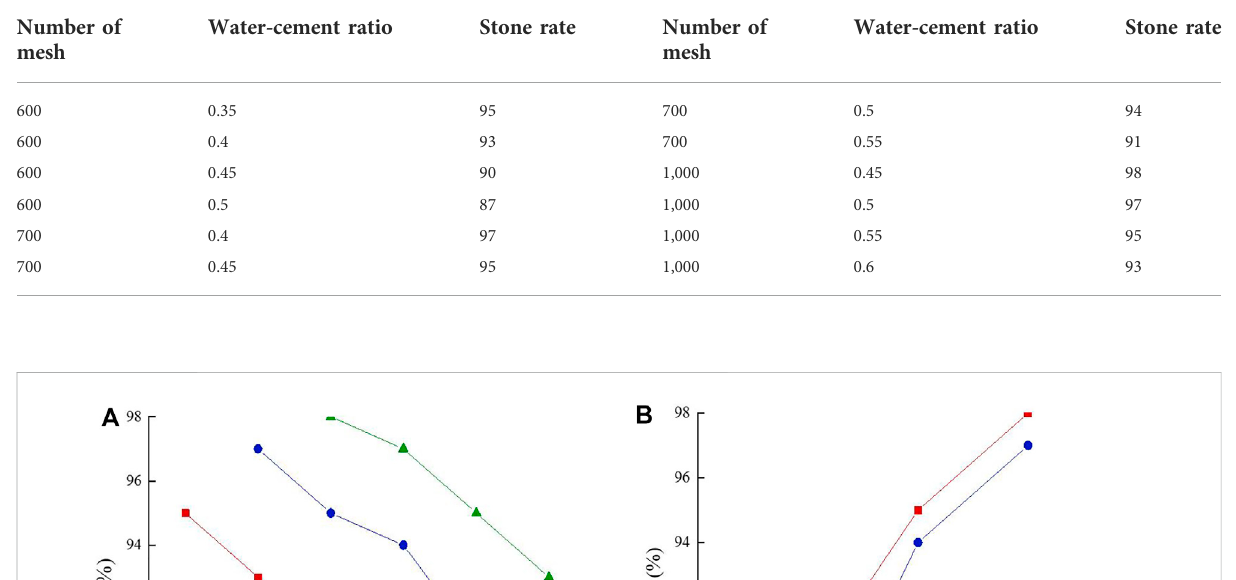
TABLE 7 Stone rate of super fi ne cement with different water-cement ratio.